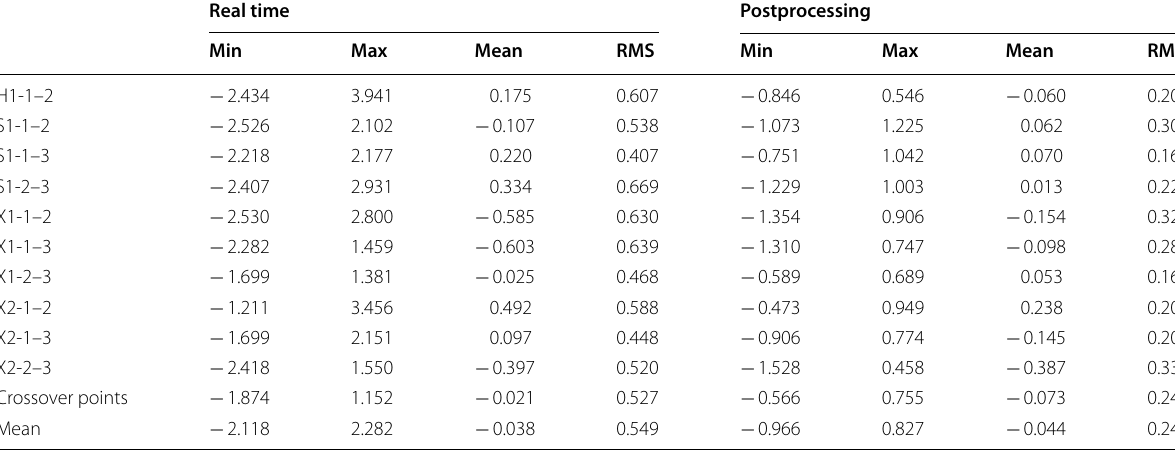
Table 6 Statistical results of GT-2M